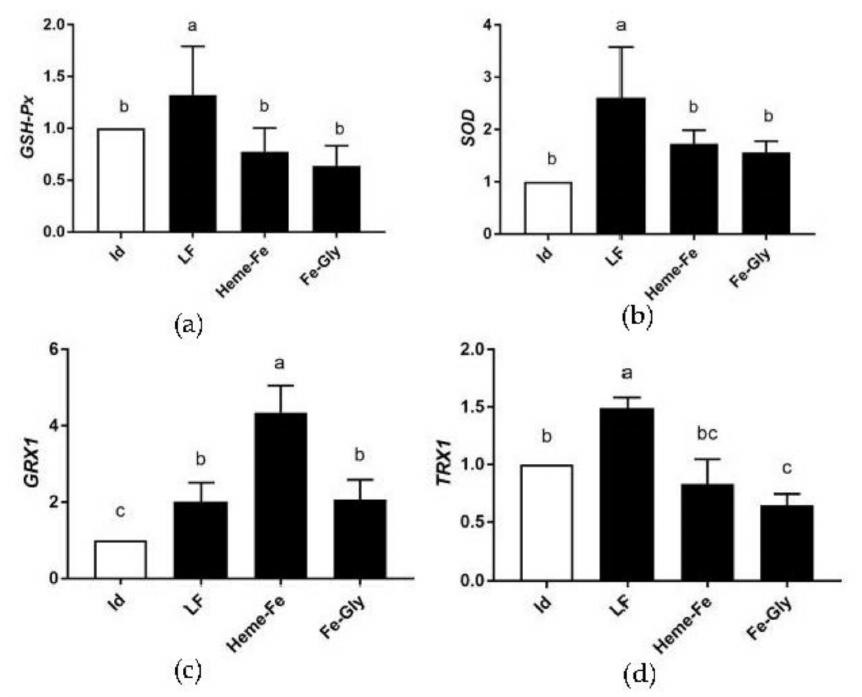
Figure 1. Effects of different iron sources on GSH-Px ( a ), SOD ( b ), GRX1 ( c ), and TRX1 ( d ) gene expression in neonate piglet heart. Id: iron deficiency group; LF: lactoferrin group; Heme-Fe: heme iron group; Fe-Gly: Fe glycinate group. Values in columns with different small letters indicate significant difference ( p <